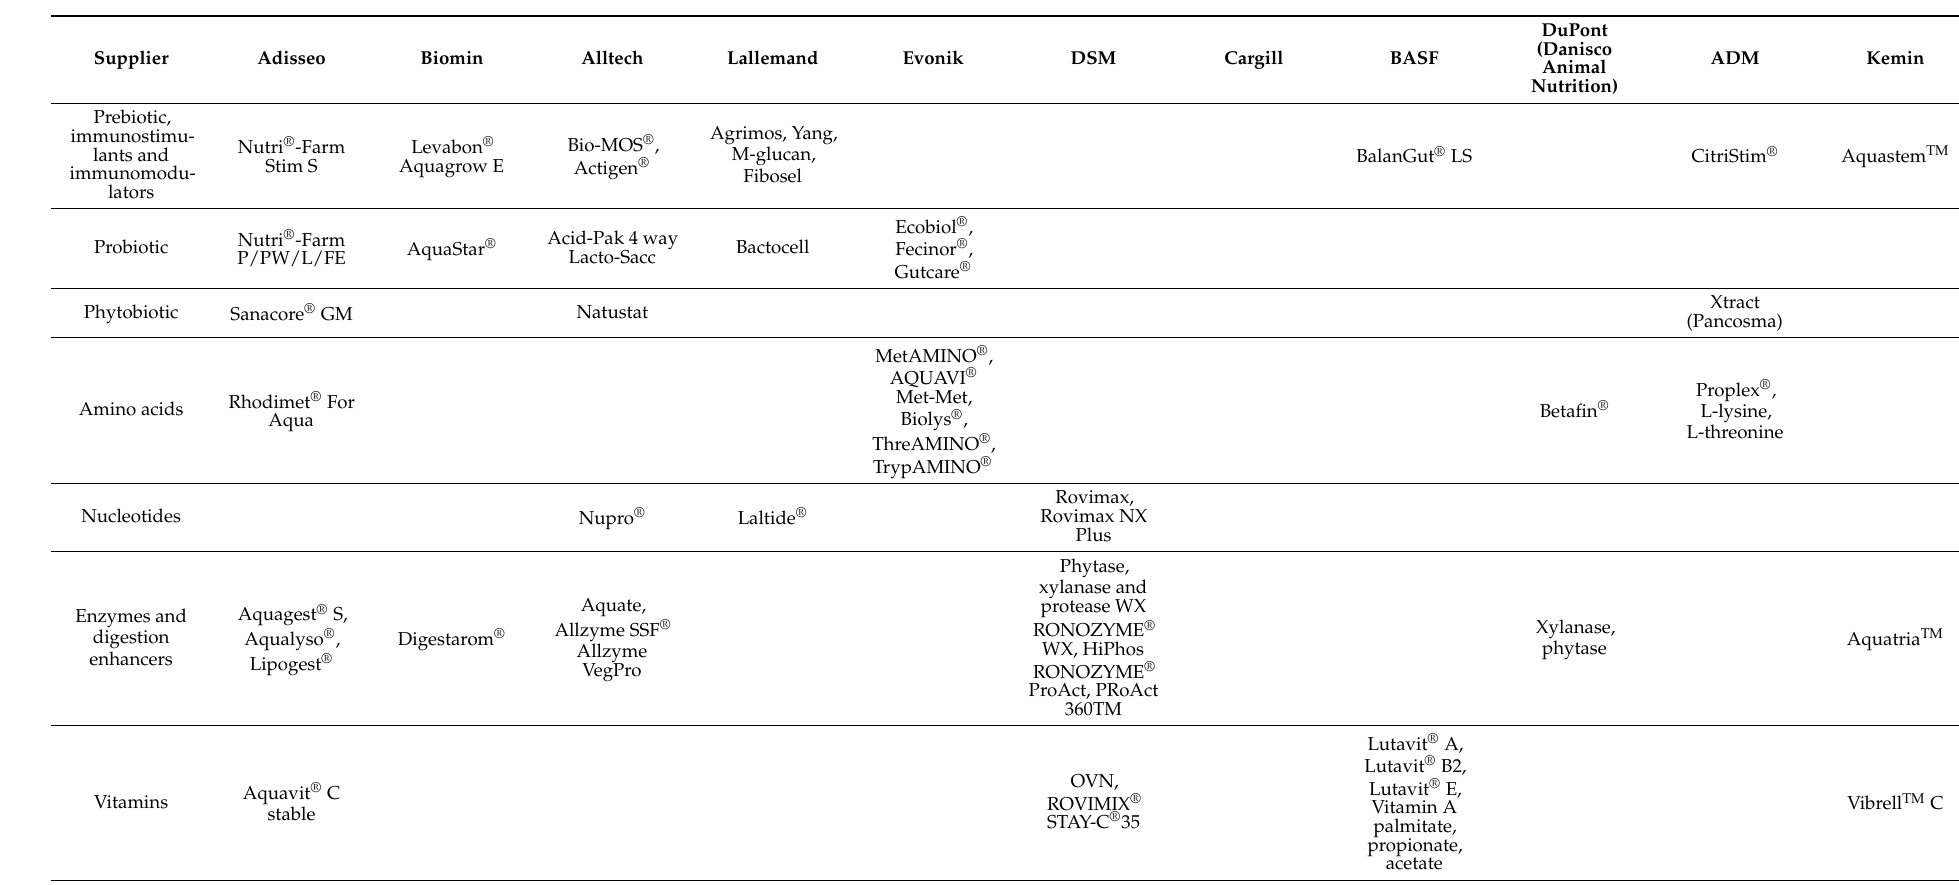
Table 7. Examples of commercial feed additives available for the shrimp